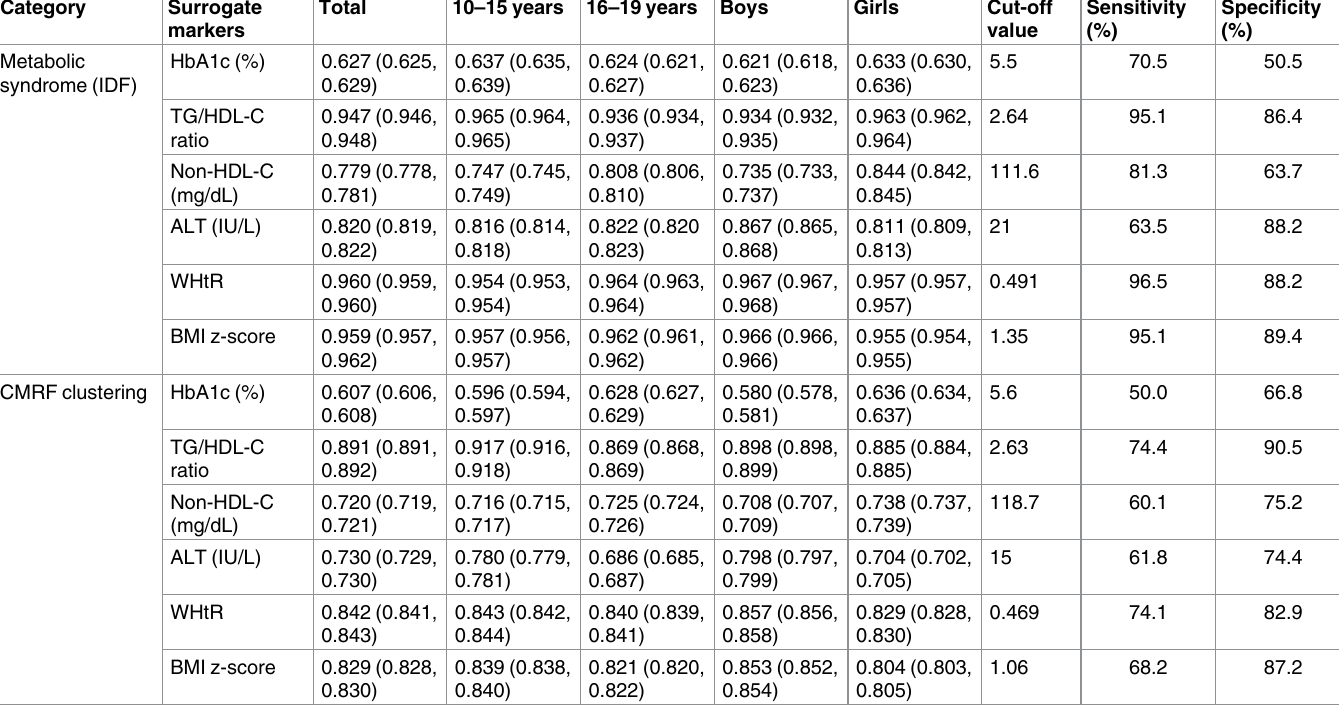
Table 3. Area under the curve (95% confidence intervals) and cut-off values of surrogate markersfor predicting metabolic syndrome and cardio- metabolic risk factor (CMRF) clustering.